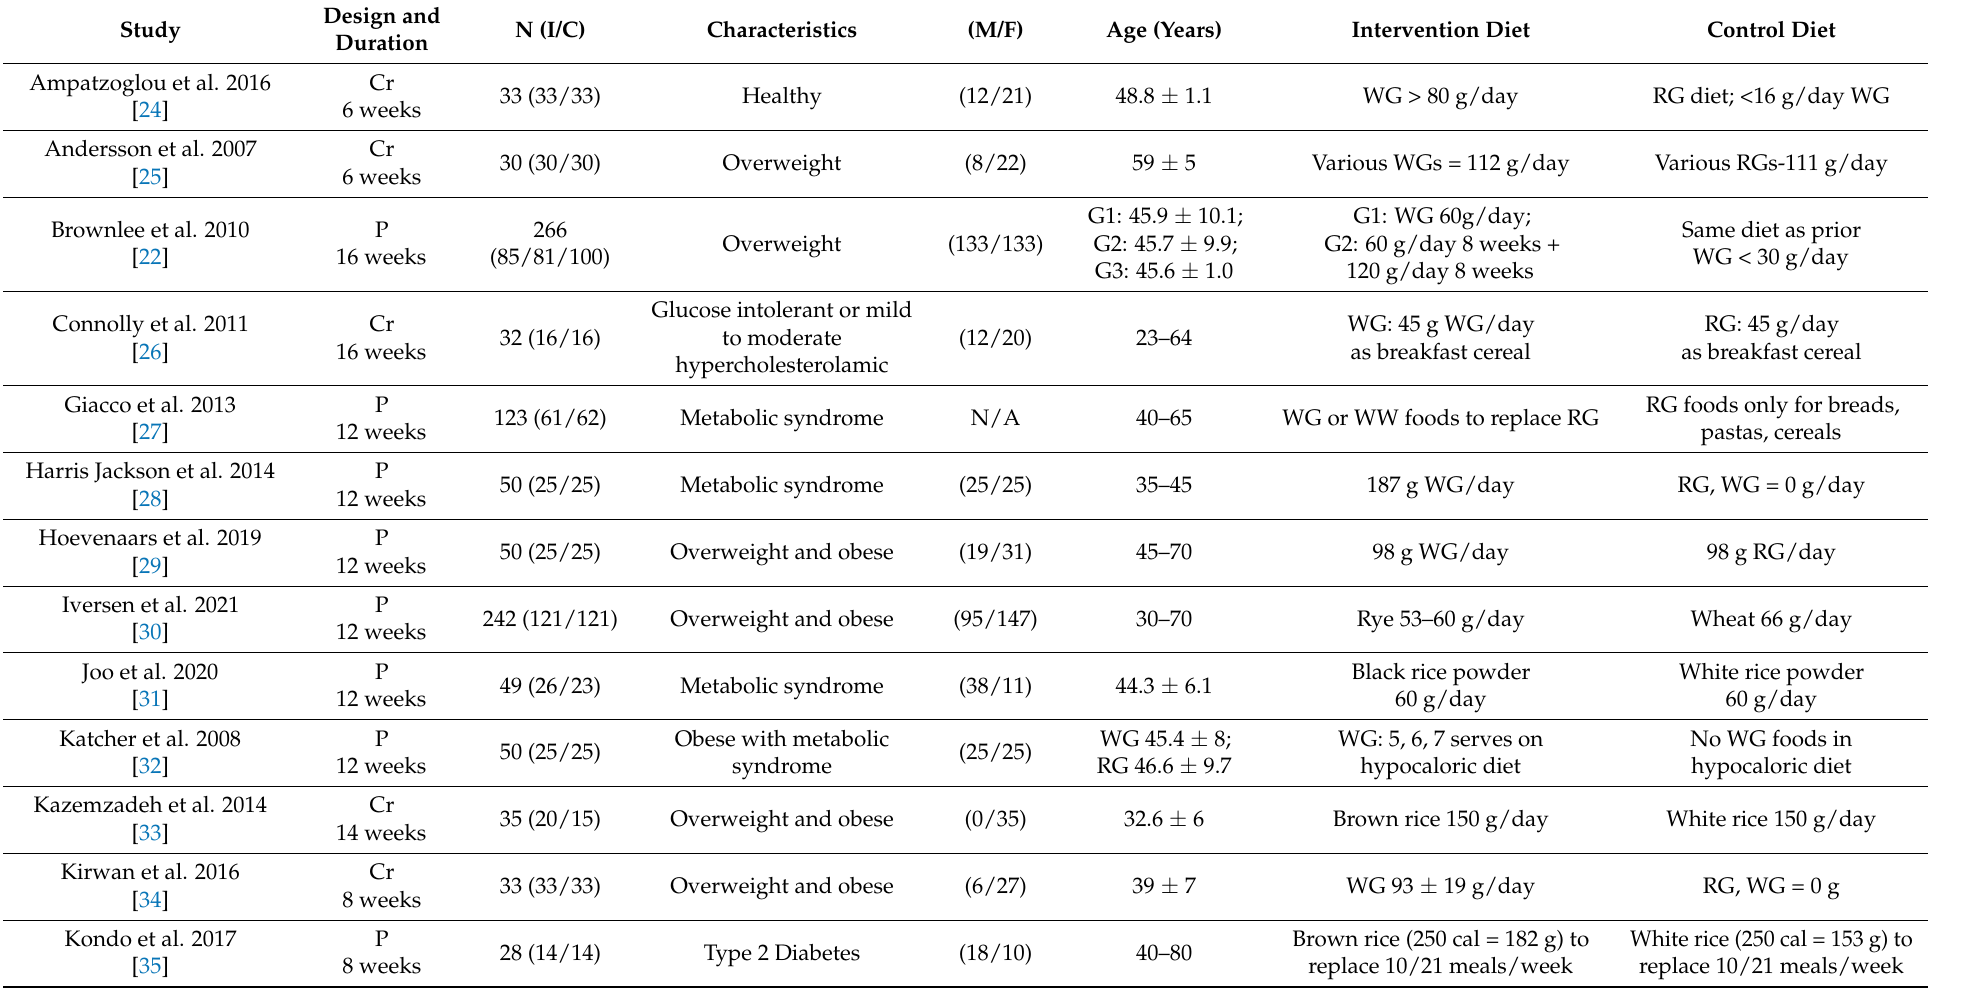
Table 1. Characteristics of studies examining whole grain consumption and inflammatory